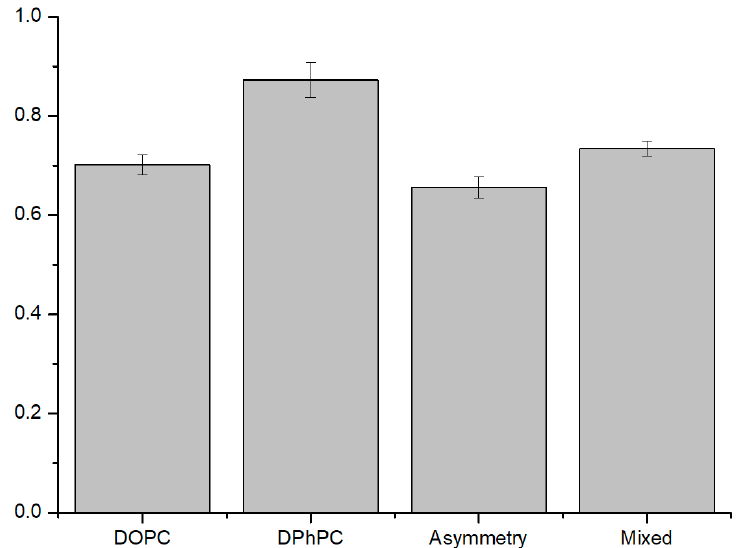
Figure 3. Graph of liposome stability in several compositions in the presence of ROS. It is a value of change in fluorescence intensity (after light illumination/before light illumination) (N = 8). The smaller the value is, the more unstable it is. Symmetric liposomes of DPhPC were the most stable, and asymmetric liposomes were the most unstable. Mixed liposomes with DPhPC and DOPC in symmetric form were more stable than with DOPC only liposomes, and DOPC only liposomes were more stable than asymmetric liposomes (Table S1).